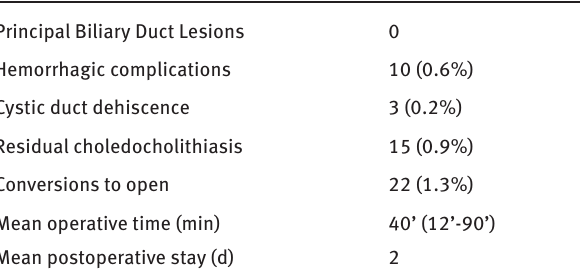
Table 1: Pathologic and Demographic